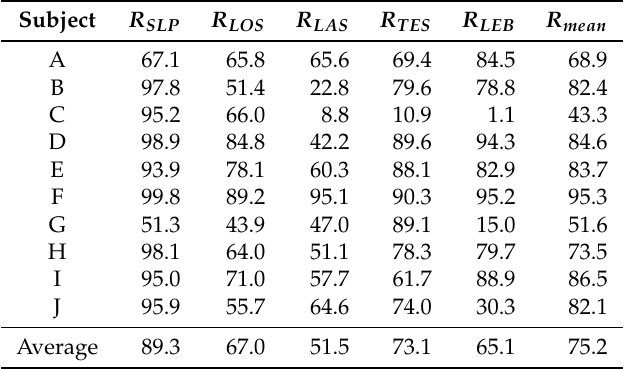
Table 6. Recognition accuracies in each subject for DDS [%].